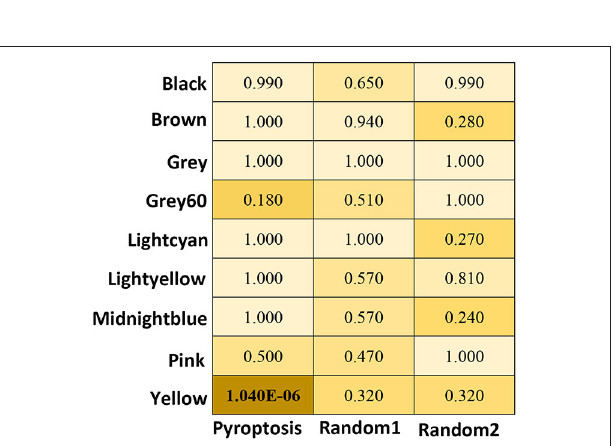
FIGURE 4 | The heat map of correlation Analysis between the module and the pyroptosis signaling pathway. P are obtained using Fisher’s exact test by GeneOverlap R package. The significant values are shows in